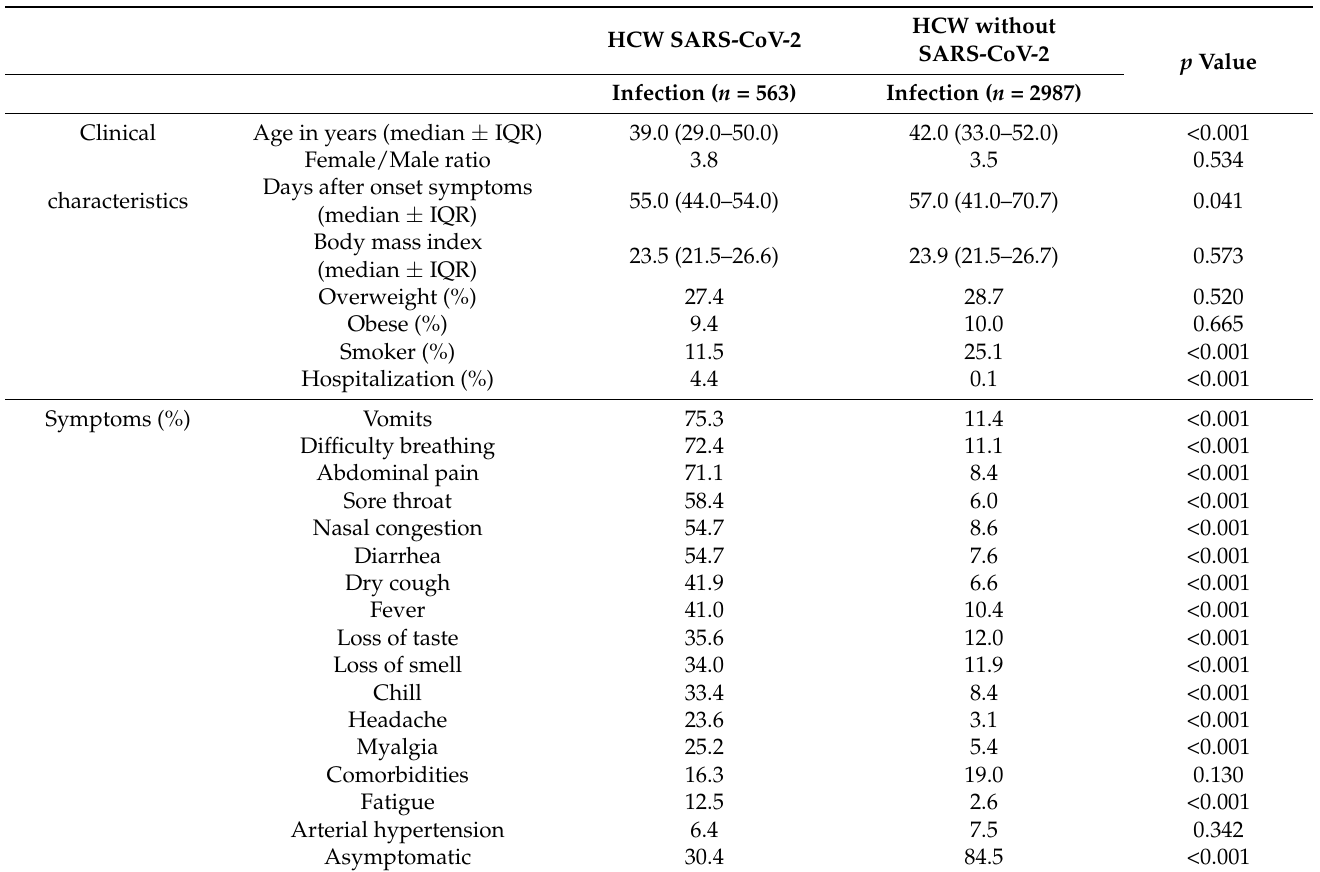
Table 1. Clinical data of healthcare workers from the study cohort ( n = 3550). HCW without HCW SARS-CoV-2